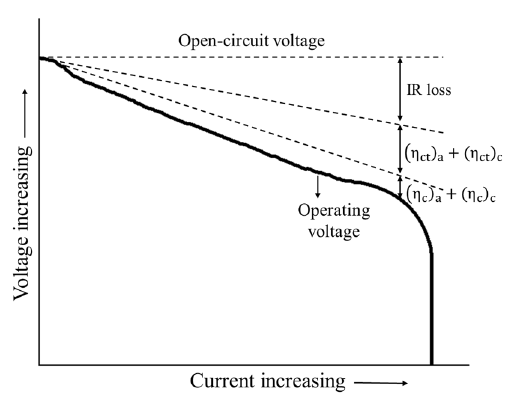
Figure 1. Typical polarization of a cell (re-elaborated from [30]).